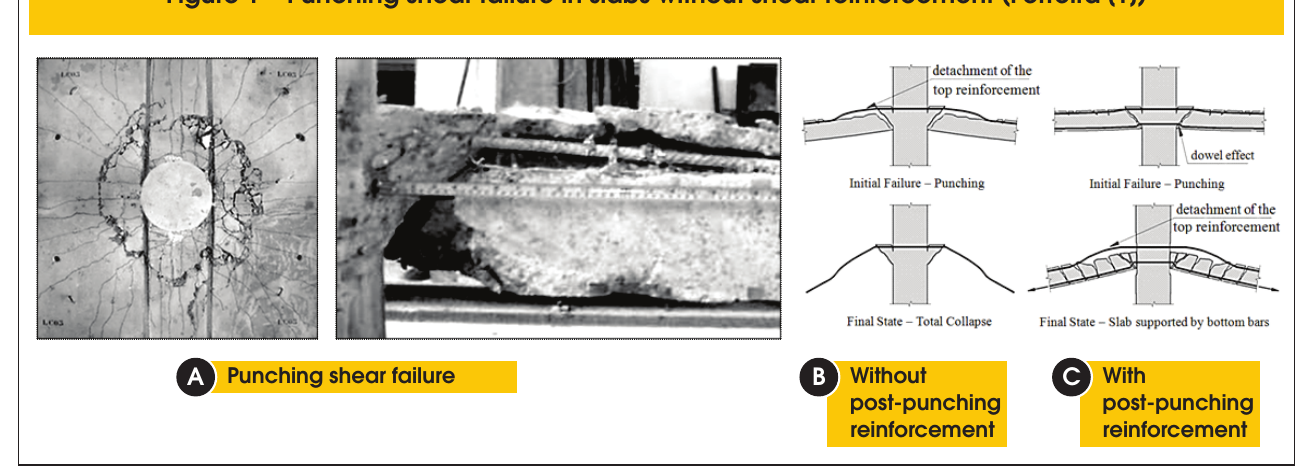
Figure 1 � Punching shear failure in slabs without shear reinforcement (Ferreira [1])